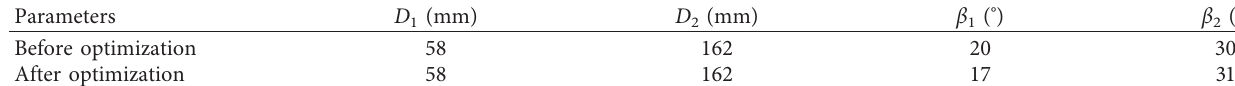
Table 9: Comparison of optimization design variables.